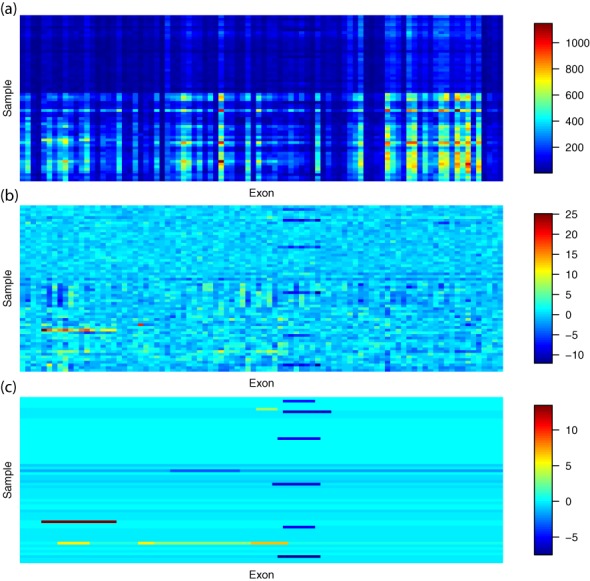
Heatmaps of raw, normalized and segmented WES read depth data from the TARGET Project. (a) Exon- and sample-wise biases and artifacts make the raw read depth data noisy and not directly reflect true copy number states. (b) CODEX's normalization procedures are performed. Heatmap of \documentclass[12pt]{minimal}
\usepackage{amsmath}
\usepackage{wasysym}
\usepackage{amsfonts}
\usepackage{amssymb}
\usepackage{amsbsy}
\usepackage{upgreek}
\usepackage{mathrsfs}
\setlength{\oddsidemargin}{-69pt}
\begin{document}
}{}${{\left( {Y - \widehat\lambda } \right)} / {\sqrt {\widehat\lambda } }}$\end{document} is shown and has a cleaner view of CNV signals. (c) CODEX's Poisson-likelihood-based segmentation procedure returns CNV calls.